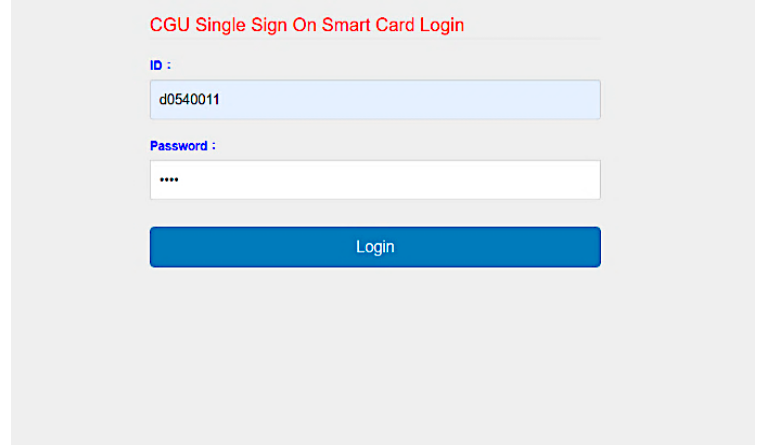
Figure 14. Interface of registration.